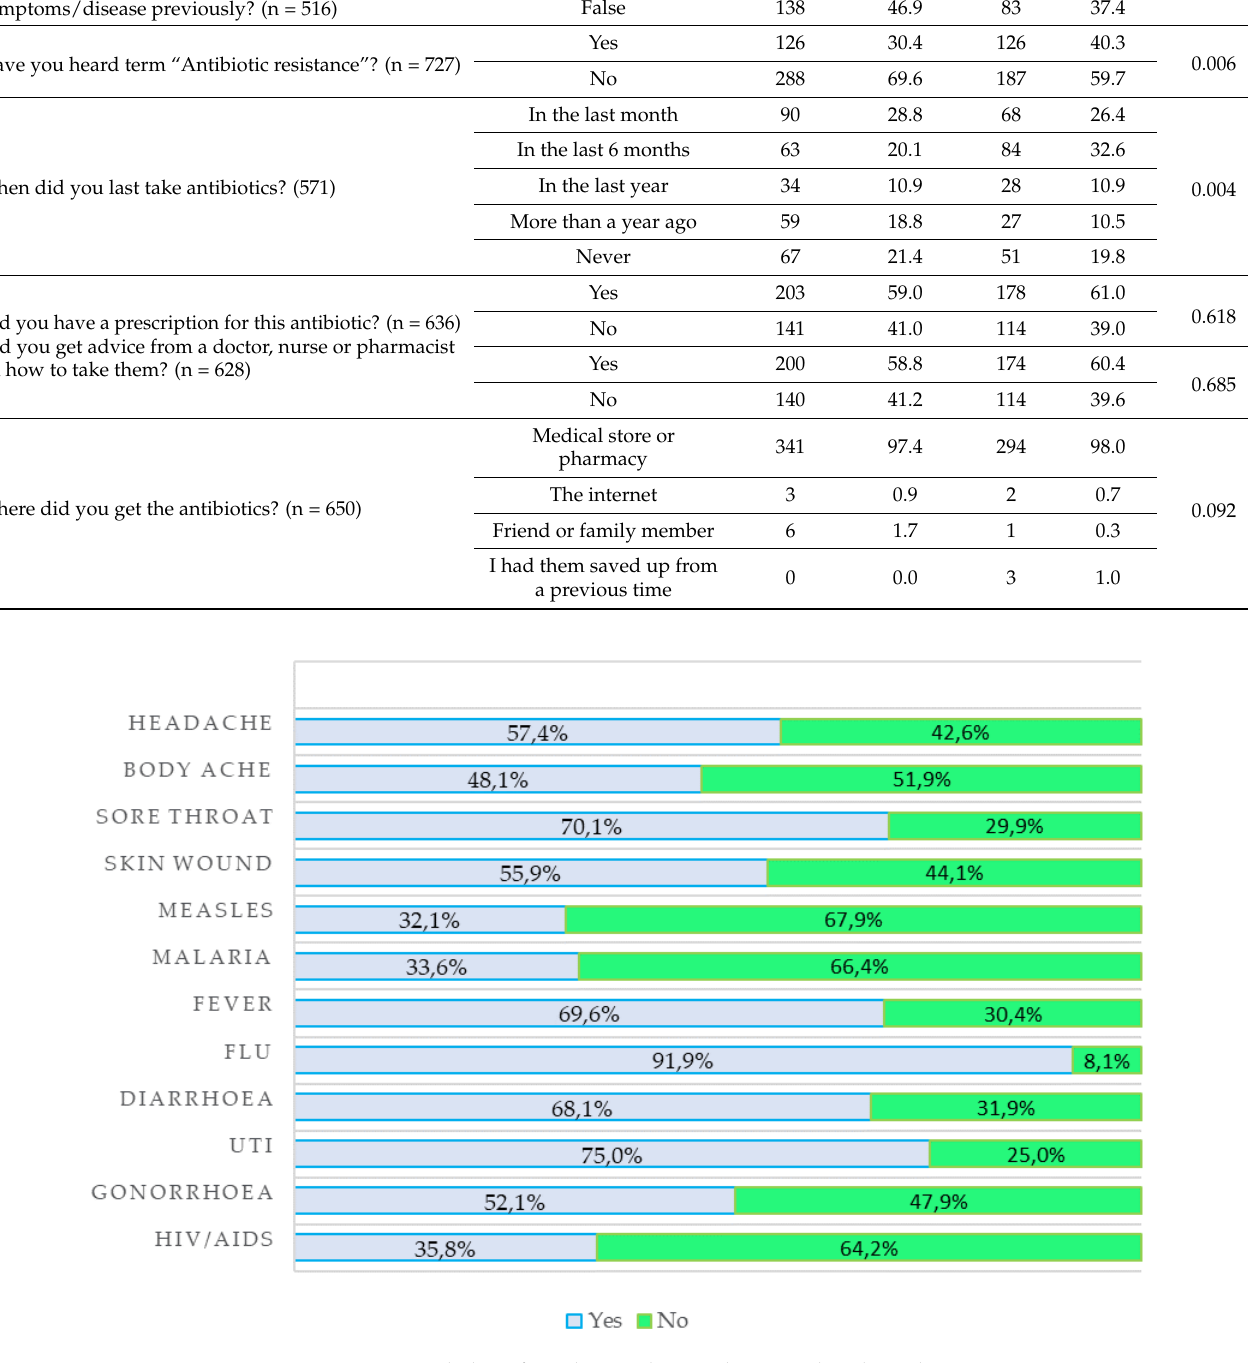
Figure 1. Knowledge of conditions that can be treated with